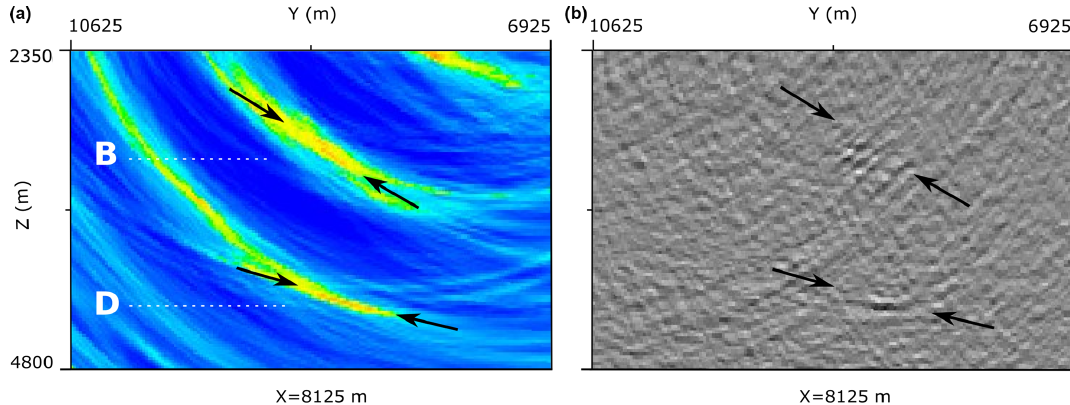
Figure 13. A zoomed-in illustration of the reflectors B and D (a) and their position shown by the arrows on the phase-consistent active seismic image (b) . Note that these slices are located at a distance of 250m in the x direction to the slices in Fig.